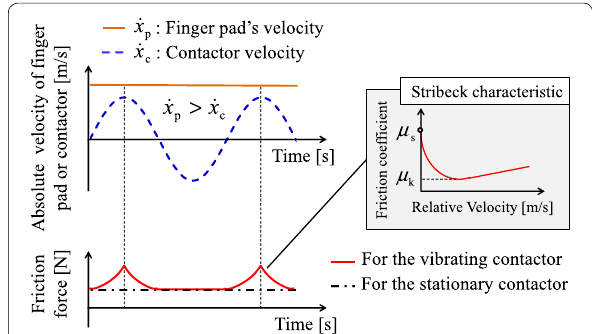
Fig. 3 Velocities of fingertip and vibrating contactor when ˙ x p > ˙ x c . Bottom Friction forces between the finger and contactor. The friction depicted by the red curve increases as the relative velocity becomes minute. Right Stribeck characteristic of friction, where µ s and µ k are the static and kinetic friction coefficients, respectively